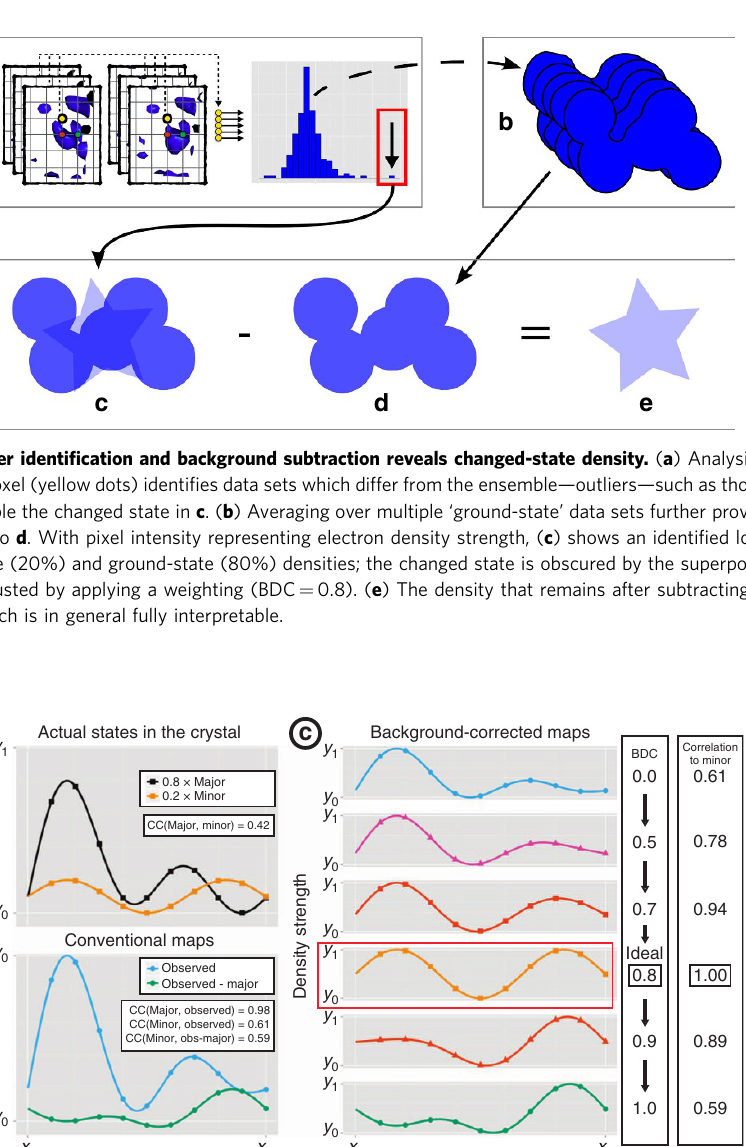
Table 1 | Hit rates from fragment screens before and after use of PanDDA. Protein Data sets